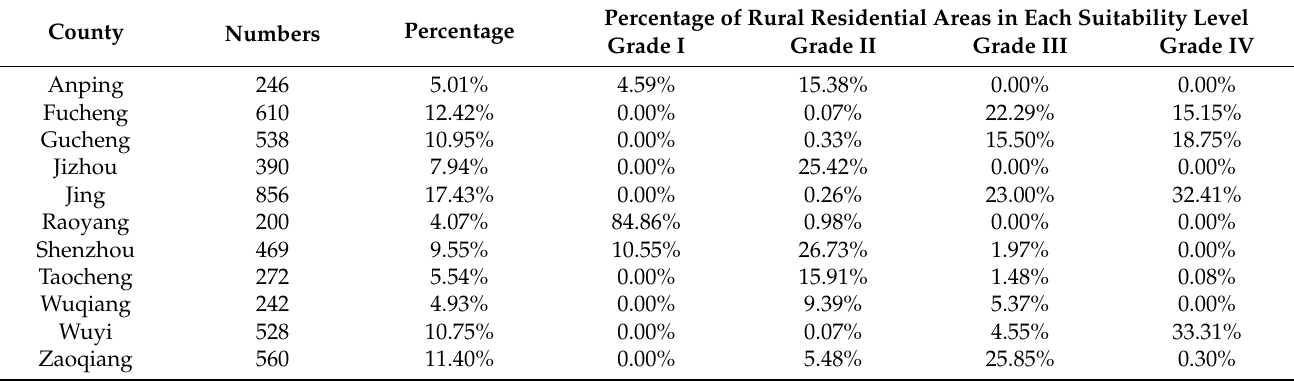
Table 5. Statistics on the suitability of rural settlement in each